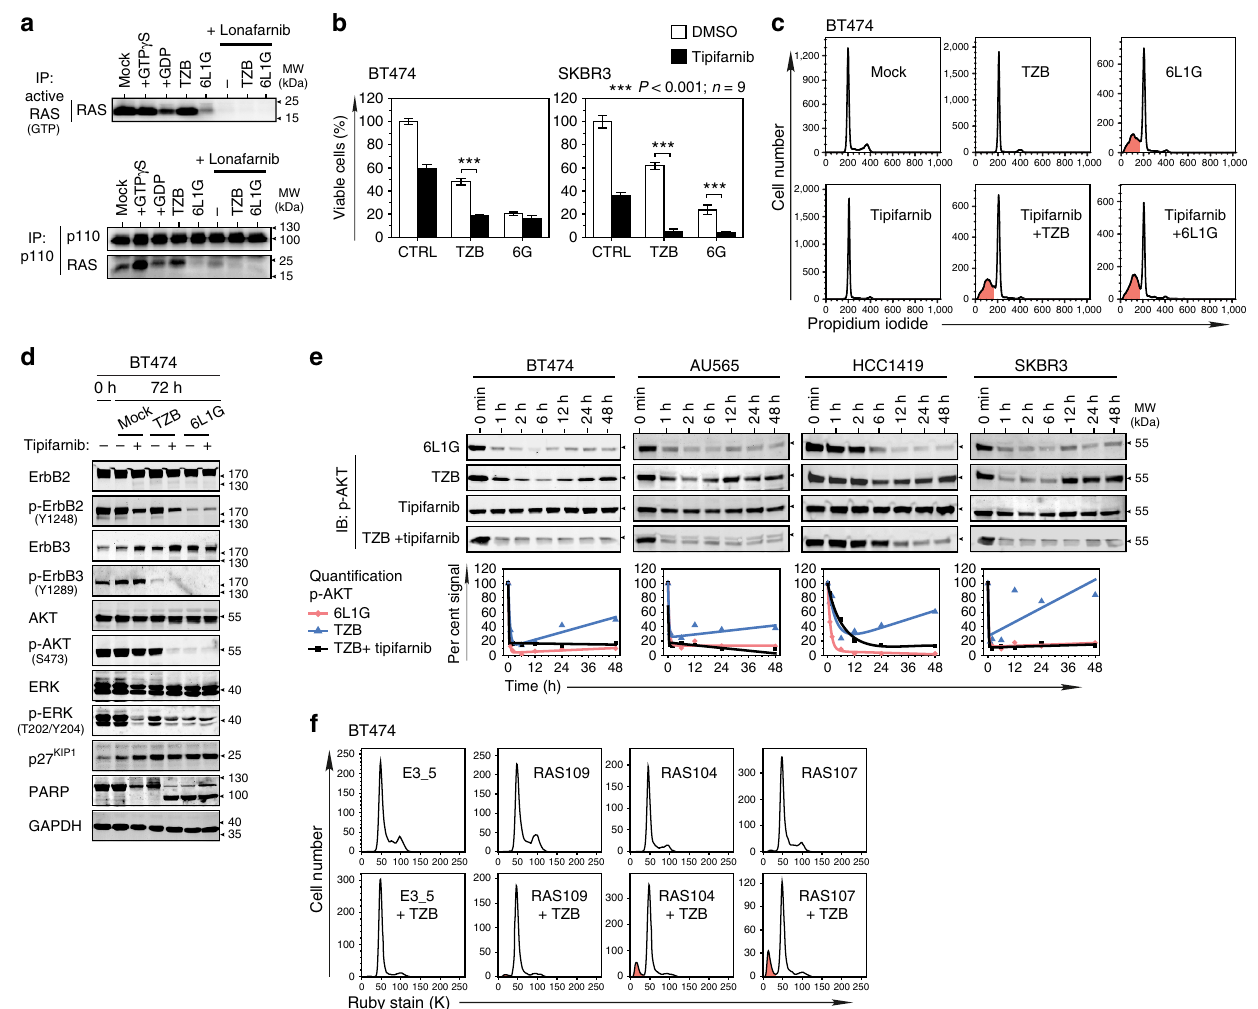
Figure 8 | RAS-PI3K crosstalk mediates AKT reactivation in the absence of p-ErbB3. ( a ) 6L1G but not TZB treatment blocks both RAS-GTP formation and RAS–p110 a interaction. RAS-GTP pull-down assay using GST-RBD beads (top) and co-immunoprecipitation of p110 a and RAS with pan-RAS immunoblot detection (bottom) after 72h of treatment of BT474 cells with 5 m M of RAS farnesyltransferase inhibitor lonafarnib alone or in combinations with 100nM TZB and 6L1G. ( b – e ) Combination treatment of TZB with RAS farnesyltransferase inhibitor blocks p-AKT rebound and triggered apoptosis. Inhibition of XTTcell proliferation ( b ), cell cycle ( c ), and downstream signalling ( d ) after 72h of treatment with 5 m M tipifarnib in combination with 100nM TZB or 6L1G (Supplementary Fig. 5G). The p-AKT rebound was quantified over 48h in e . In b – e , tipifarnib was used at 5 m M concentration in BT474, AU565, HCC1419 and at 1 m M in SKBR3 cells. Note that ERK phosphorylation was inhibited by both 5 m M tipifarnib and lonafarnib (two-sided, unpaired Welch’s t -test). ( f ) Selective RAS inhibitors RAS104 and RAS107, blocking the RAS-RBD binding interface, induce apoptosis in combination with TZB after 3 days treatment in BT474 cells. The non-interfering RAS binder RAS109 or the non-targeted DARPin E3_5 were used as controls with minute or no pro-apoptotic activity, respectively. BT474 cells were transfected with plasmids expressing RAS104, RAS107, RAS109 or E3_5 GFP-fusions and treated with 100nM TZB 24h later (Supplementary Fig. 5B). The PFA-fixed cells were stained with Vybrant Ruby stain, and the transfected GFP-positive population was analysed by FACS for cell cycle distribution.